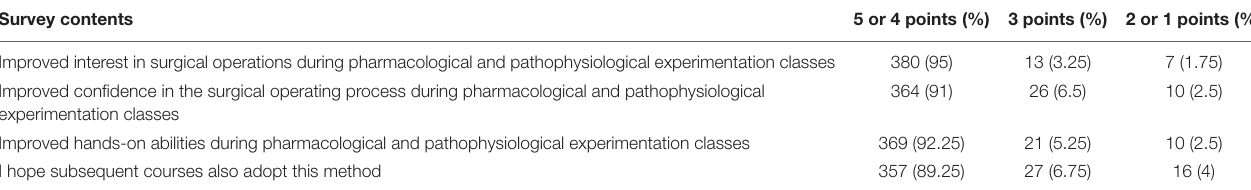
TABLE 3 | Survey feedback of the effect on the student learning process in courses at a later stage ( n =